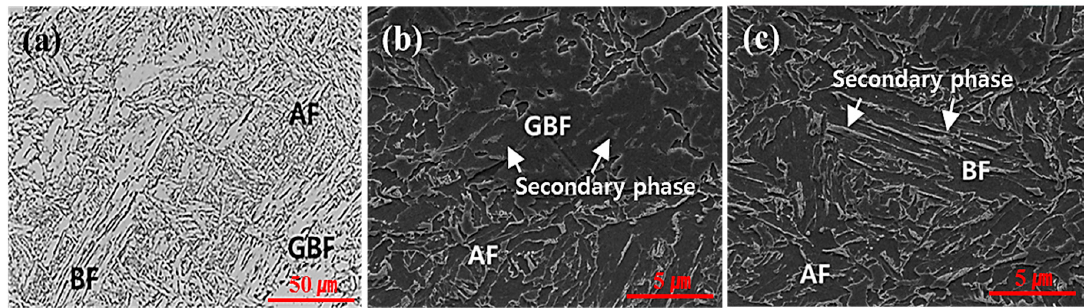
Figure 3. Various microstructures of the base metal: ( a ) LOM image of BM; and ( b ), ( c ) SEM images of AF, BF, and GBF.